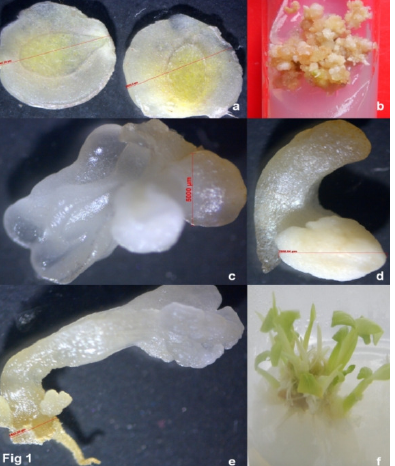
Fig. 1. a) Transverse thin cell layer sections (tTCL) of in vitro derived microrhizome. b) Induction of callus on the medium supplemented with 2mg/L 2,4-D. c) Observation of embryo maturation and redifferentiation at MS medium containing 0.2 mg/L 2,4-D and 6 mg/L BAP. d) Appearance of small protuberances from the redifferenting calli of size 1000-6000 µm after 3 weeks of culture. e) Complete plant regeneration